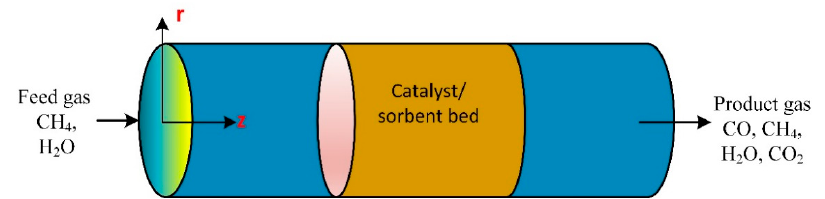
Figure 6. A schematic diagram of fixed bed catalytic reactor [72].